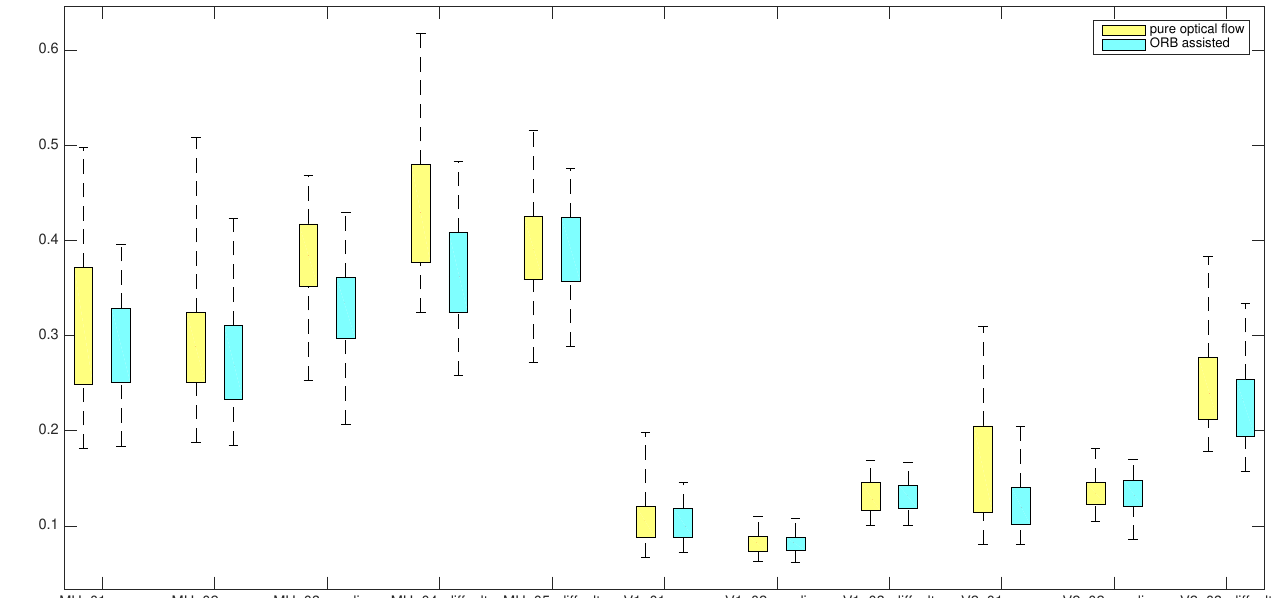
Figure 6. Boxplot summary of experimental results in terms of translation root-mean-square errors (RMSEs) of estimated trajectories. As can be seen, with ORB descriptor assistance the estimation is generally of higher precision, reflected in the lower position and narrower height of the corresponding box’s range for most